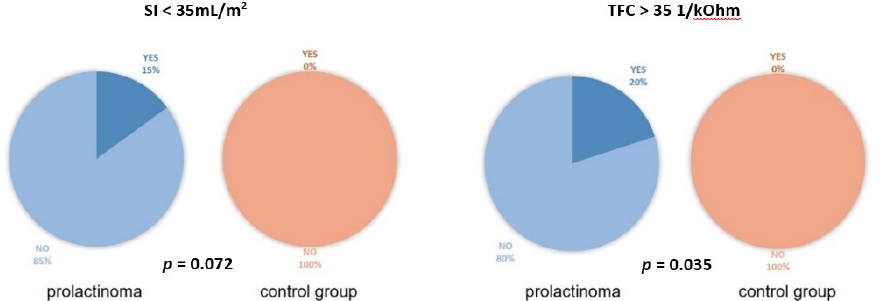
Figure 1. The proportion of low stroke volume index (SI) and high thoracic fluid content (TFC) in the prolactinoma and the control group.